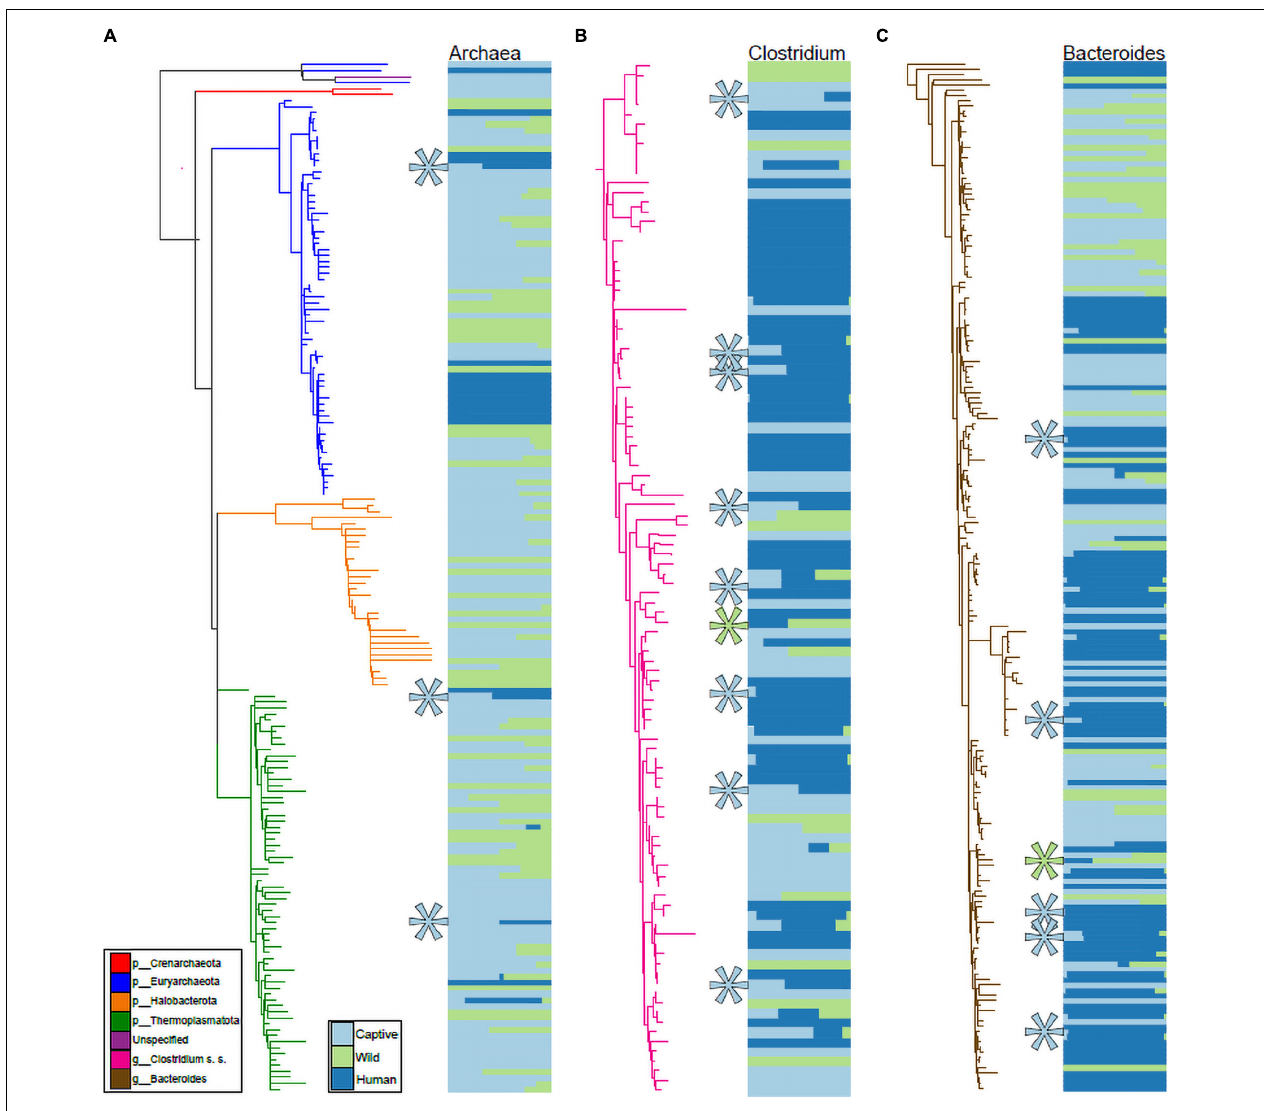
FIGURE 4 | Phylogenetic distributions of Archaeal, Clostridium, and Bacteroides ASVs shared exclusively by humans and captive mammals. Phylogenies in (A–C) show relationships among ASVs in humans, Rhinocerotidae, Equidae, Canidae, and Cercopithecidae belonging to the Archaea (A) , Clostridium sensu stricto (B) , and Bacteroides (C) . Colors of branches correspond to bacterial taxa as indicated by the leftmost inset in (A) . Colors of horizontal bars indicate the relative abundance of each ASV in captive mammal, wild mammal, or human hosts, as indicated by the rightmost inset in (A) . Relative sizes of horizontal bars are scaled to reflect the mean relative abundance of the ASV in each of the three sample categories. Teal asterisks in (A–C) indicate ASVs shared by captive mammals and humans but not found in wild mammals (i.e., ASVs displaying distributions consistent with transfer from humans to captive mammals), whereas green asterisks indicate ASVs shared by wild mammals and humans but not found in captive